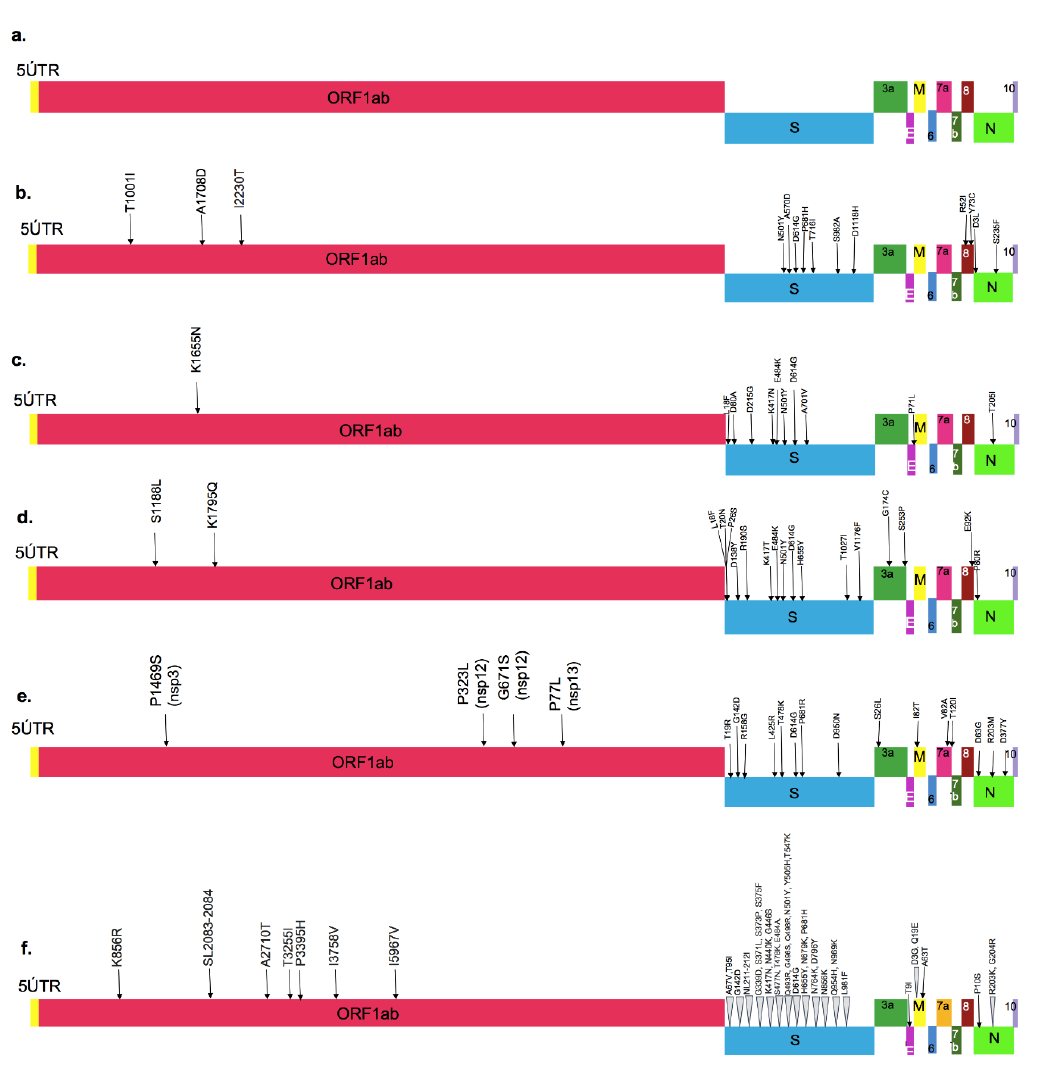
Figure 2. Major amino acid mutations marked on the entire SARS-CoV-2 sequence: ( a ) Wild-type strain, ( b ) Alpha variant, ( c ) Beta variant, ( d ) Gamma variant, ( e ) Delta variant and ( f ) Omicron variant. (M: membrane protein, E: envelope protein, S: Spike protein, N: Nucleocapsid protein, ORF: Open Reading Frame, UTR: Untranslated Region).